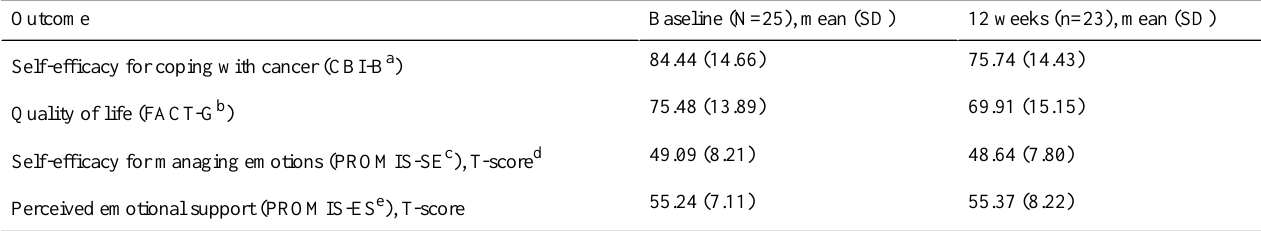
Table 2. Mean scores for patient-reported outcomes at baseline and 12